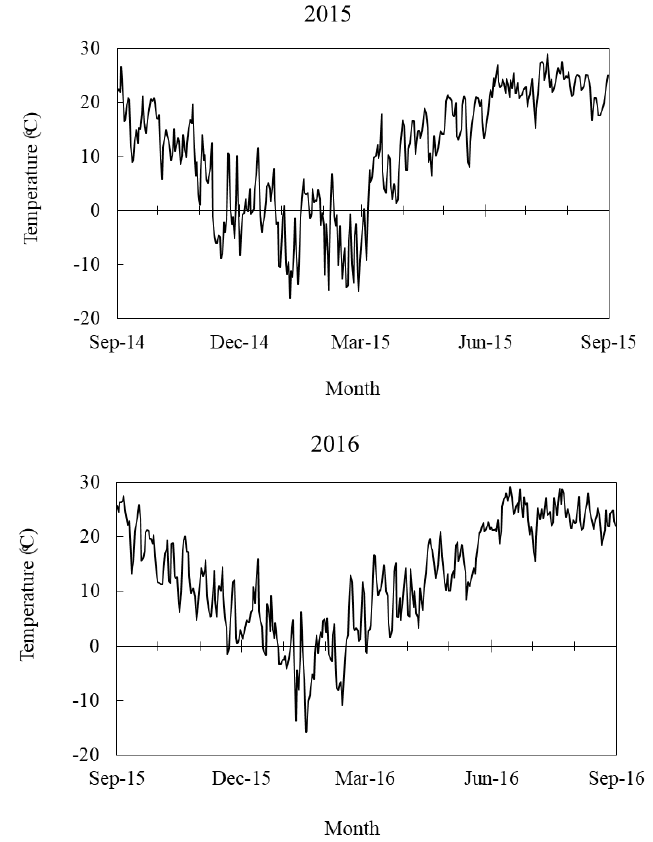
Figure 2. Daily average air temperature (°C) for the years of 2015 and 2016. Sep, September; Dec, December; Mar, March; Jun, June.